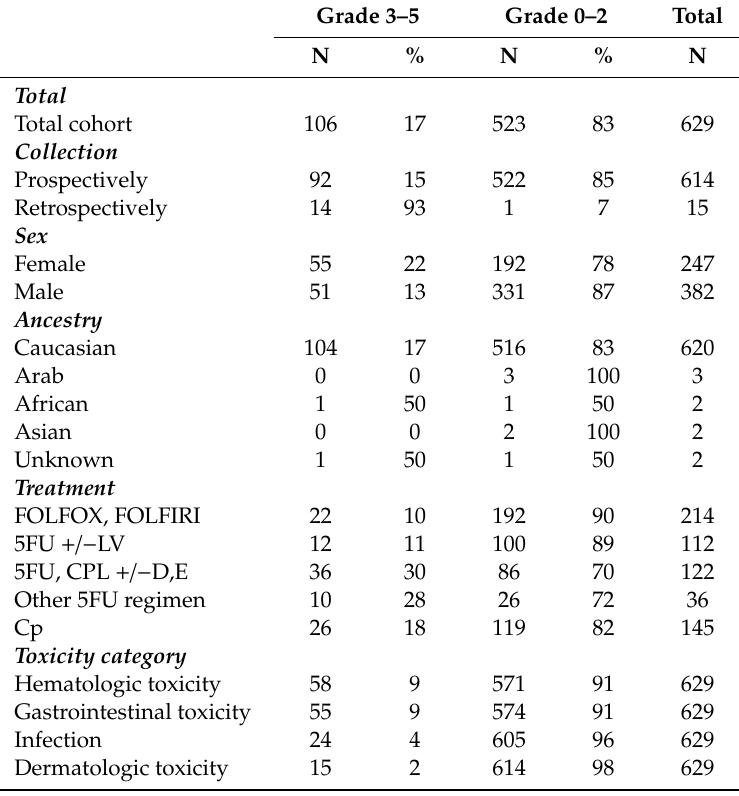
Table 1. Clinical, demographic, and toxicity data. The cohort consisted of 629 participants. FOLFOX: chemotherapy regimen based on a combination of LV, 5FU (5-fluorouracil), and oxaliplatin; FOLFIRI: chemotherapy regimen based on a combination of LV, 5FU, and irinotecan; Cp: capecitabine; CPL: cis-or carboplatin; D: docetaxel; E: epirubicin; LV: